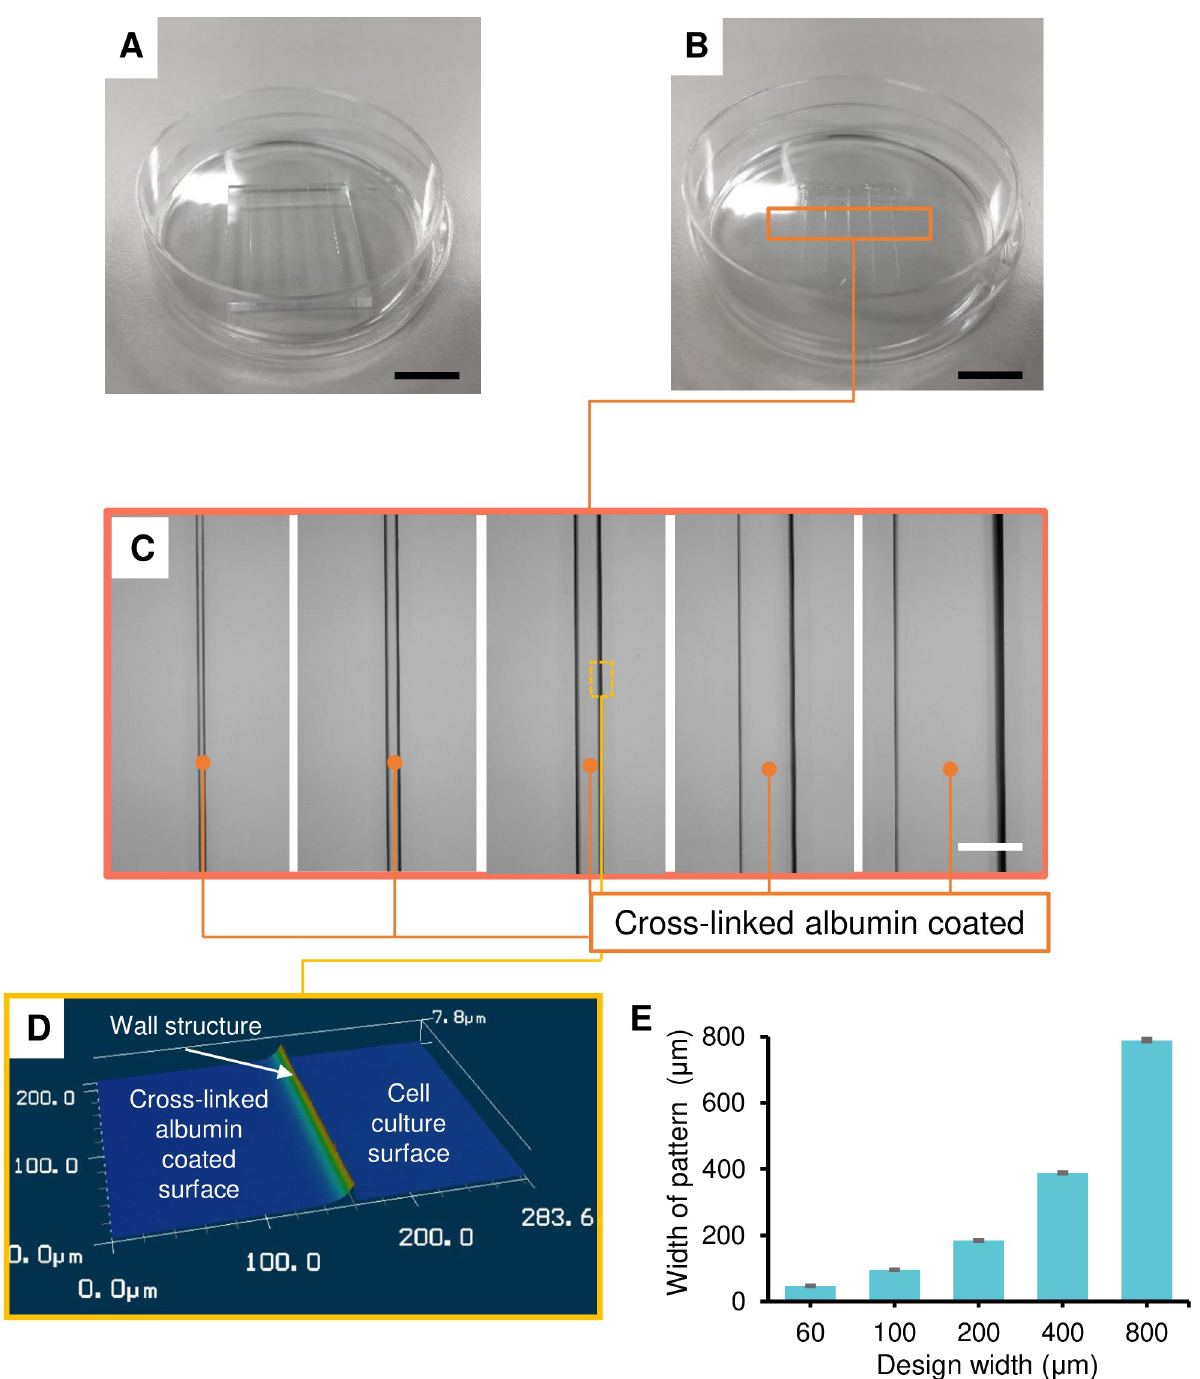
Fig 2. Microstructure of cross-linked albumin. (A) PDMS micro-mold (height: 200 μ m) and (B) the microstructure on a cell culture surface. (C) Microphotographs and (D) three-dimensional shape of the microstructure of the cross-linked albumin pattern; the black bar indicates 1 cm and the white bar indicates 400 μ m. (E) The graph shows the width of the cross-linked albumin pattern (mean ± SD, n = 5).